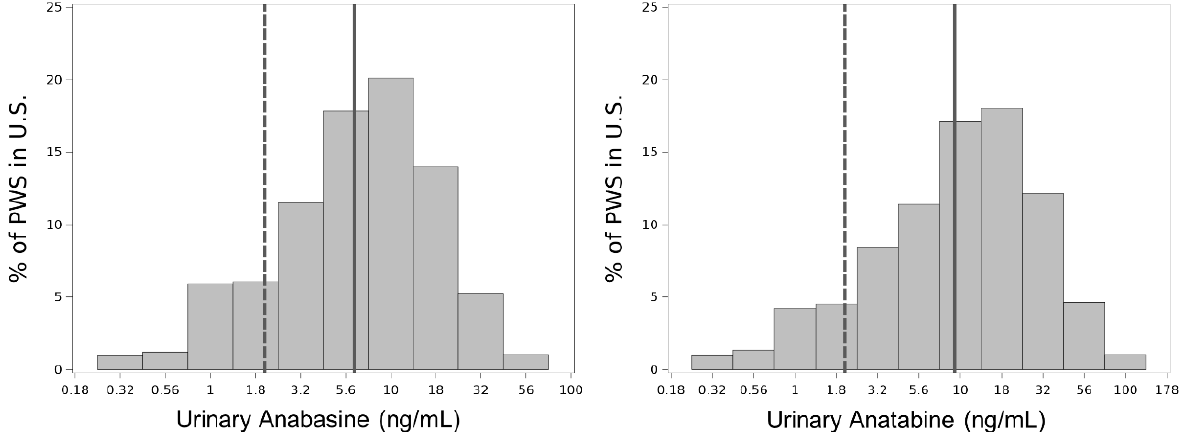
Figure 3. Weighted histograms of log 10 -transformed urinary anabasine and anatabine levels in people who smoke daily ( n = 721). Frequency is presented as a percentage of people who smoke in the U.S. The presented log-transformed concentrations were exponentiated to simplify interpretation. Geometric means and cut points of each biomarker are indicated by solid and dashed gray lines, respectively.